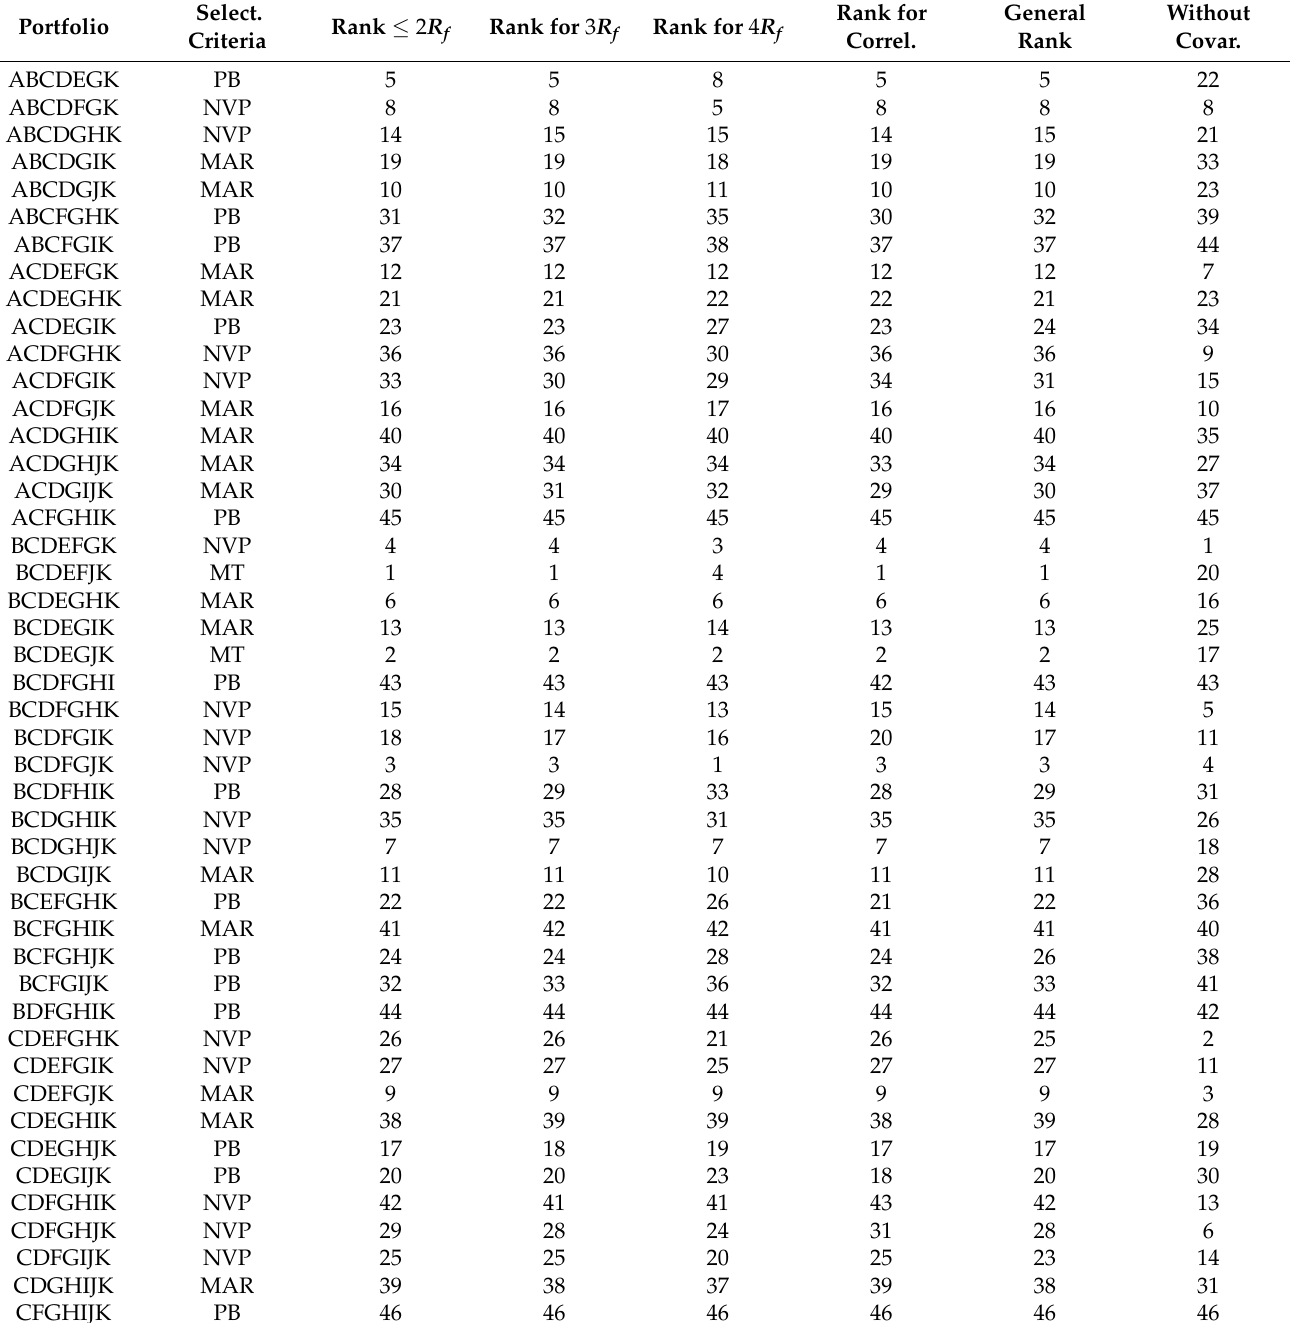
Table 6. Results of Monte Carlo